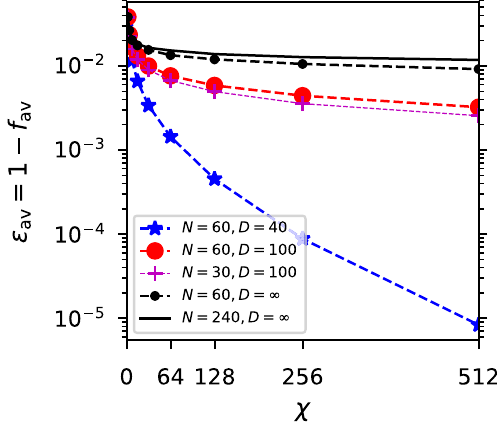
FIG. 4. Effective 2-qubit gate fidelity f as a function of the FIG. 5. Geometric average of the residual error per gate ϵ n 1 − f depth D of the circuit for χ ¼ 64 and the control- Z gate for as a function of the bond dimension χ . The average is av N ¼ 40 (red) and N ¼ 60 (magenta). The thin lines correspond to performed over the entire circuit except for the black curves the geometric average of f ( D ¼ ∞ ) where the average is restricted to the regime where the over one full sequence, i.e., all the n fidelity has reached its asymptotic value ( 100 ≤ D ≤ 200 ); see 2-qubit gates performed between depth D − 2 and depth D Fig. 4. For the largest system N ¼ 240 , we have also excluded the ( N − 1 2-qubit gates). The thick dashed lines correspond to f gates on the edges of the system in our calculation as they have by , the geometric average of f over all 2-qubit gates since the n av construction perfect fidelity. The fluctuations of the average beginning of the circuit up to depth D . A single realization of the fidelity with different circuits are smaller than the size of the circuit has been used for each curve.